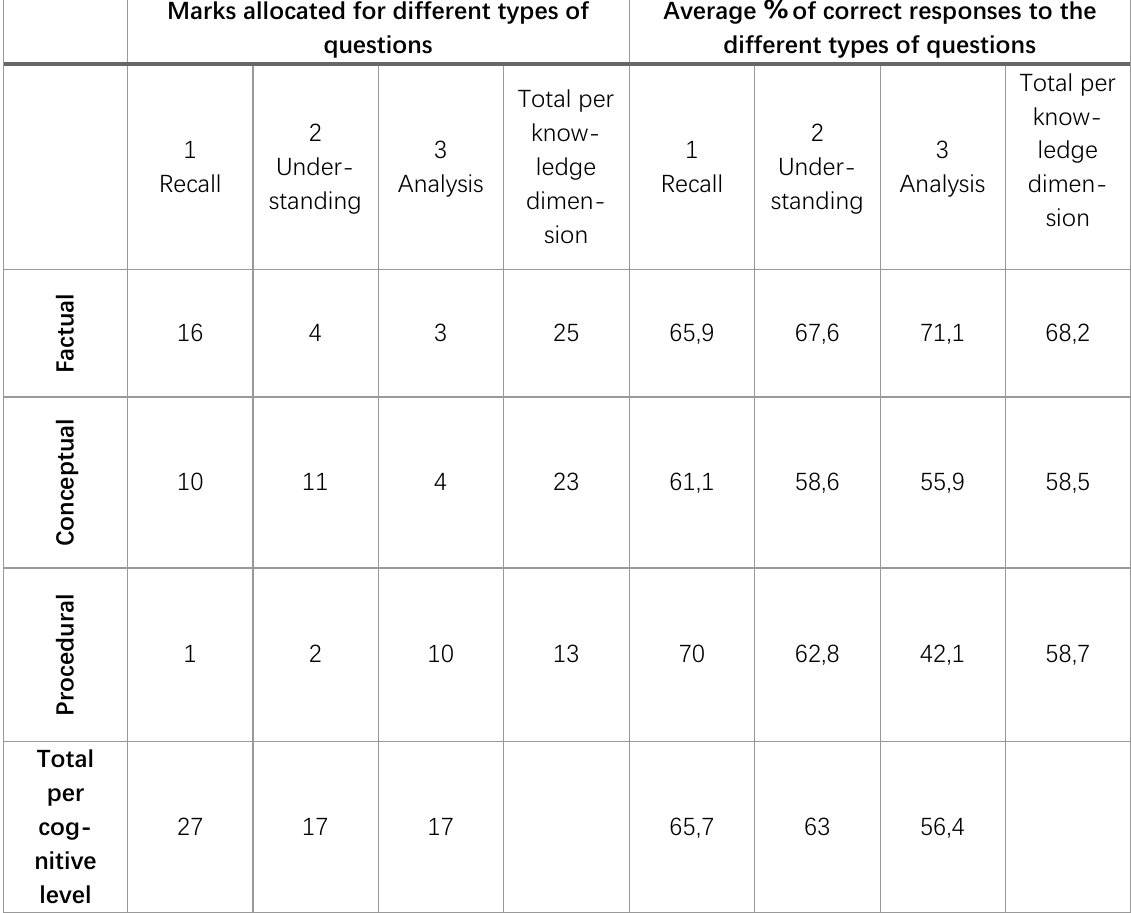
Table 3 : Mark allocation in relation to marks attained for test questions Marks allocated for different types